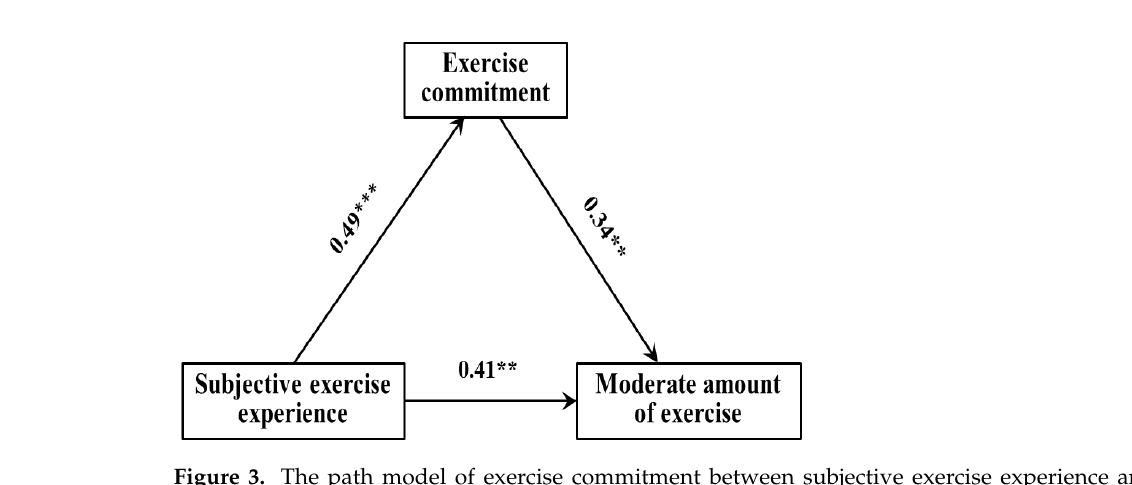
Figure 2. The path model of exercise commitment between subjective exercise experience and low exercise amount. * p < 0.05; ** p < 0.01.